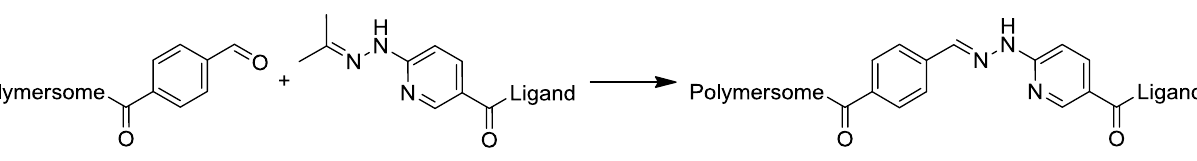
Figure 7. Specific reaction between 4FB modified polymersomes and HyNic modified ligands (e.g., proteins) forms a stable bis-aryl hydrazone bond that links the ligand to the